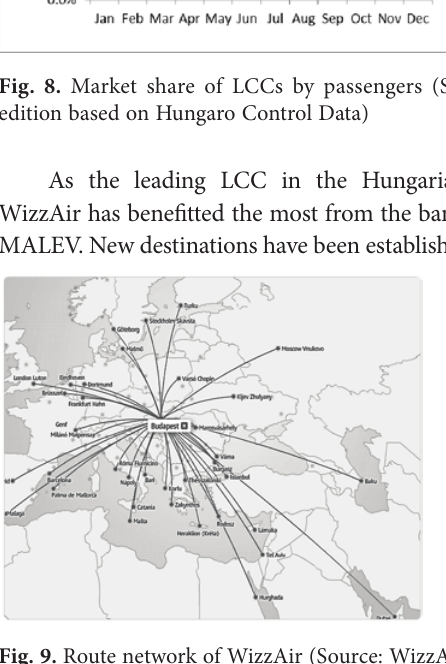
fig. 9. Route network of WizzAir (Source: